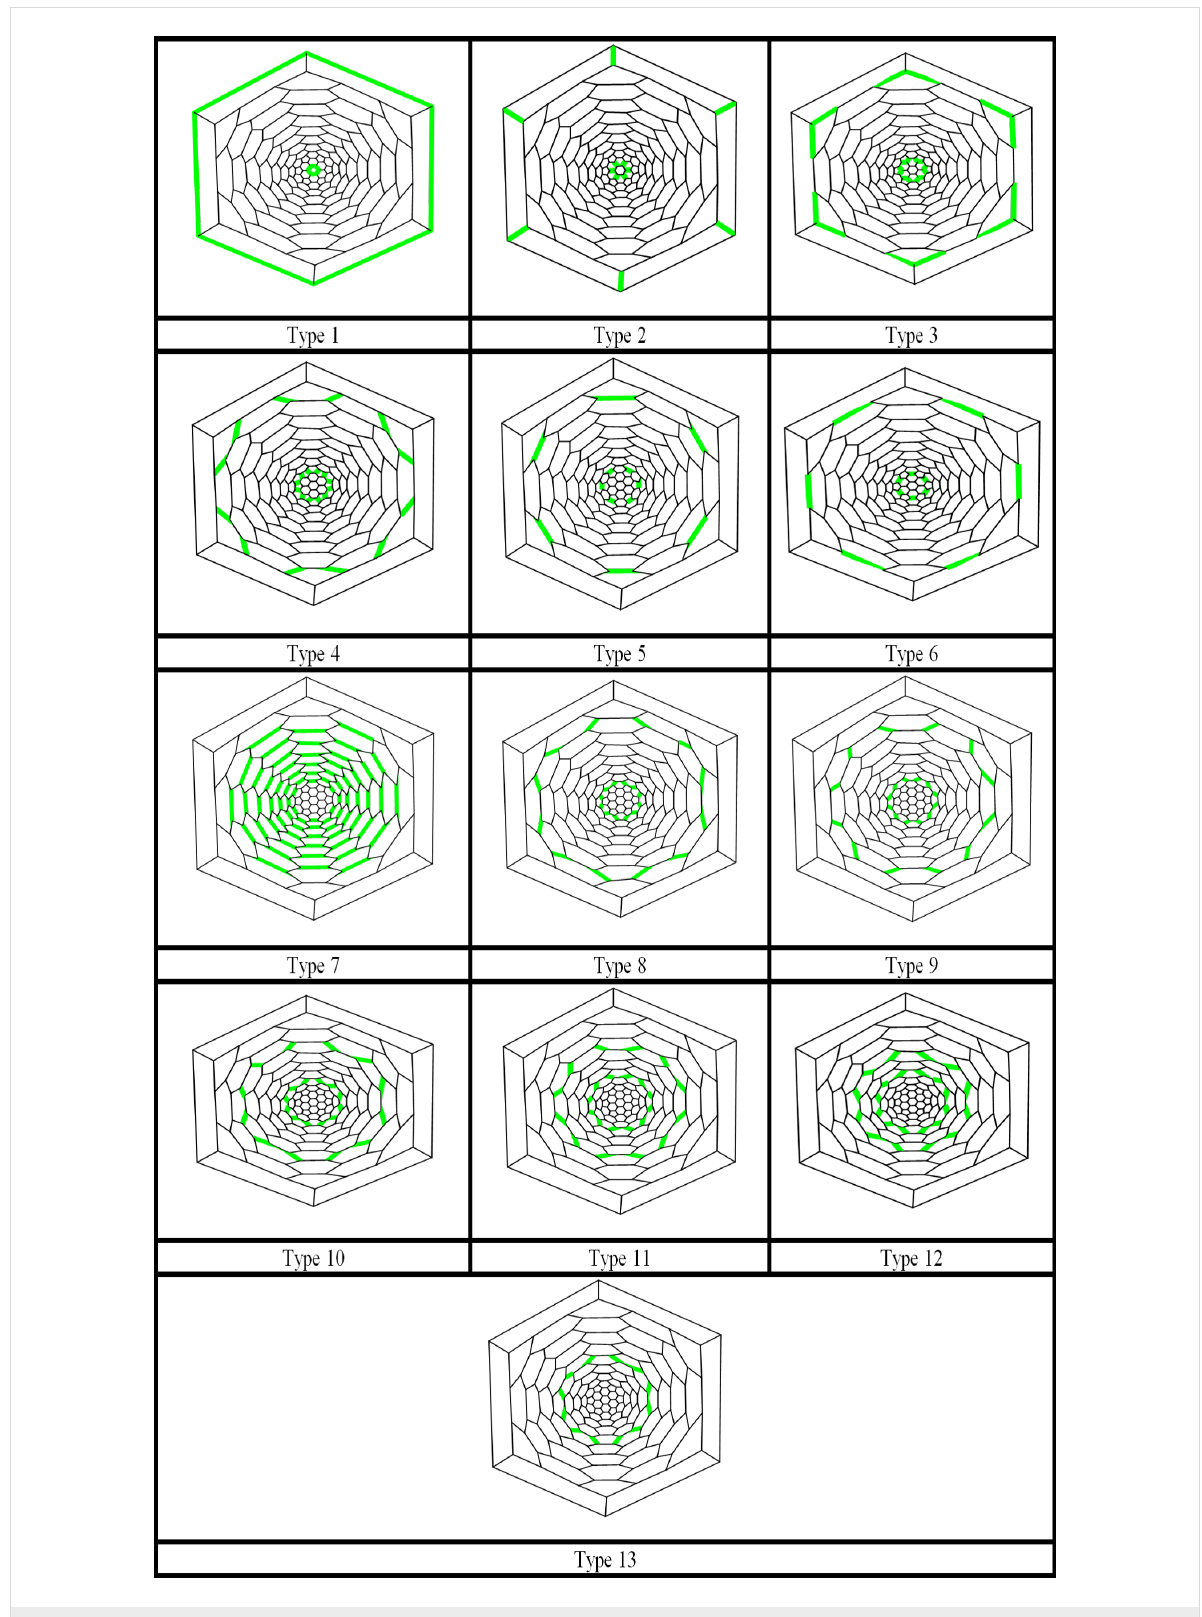
Figure 4: Thirteen different types of edges in F n , n is